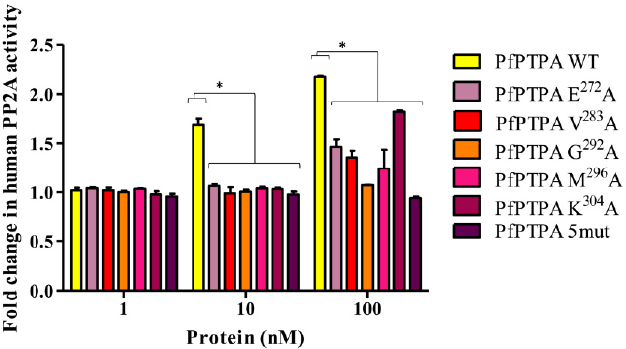
Figure 4. Effect of wild type and mutated PfPTPA proteins on PP2A activity. The